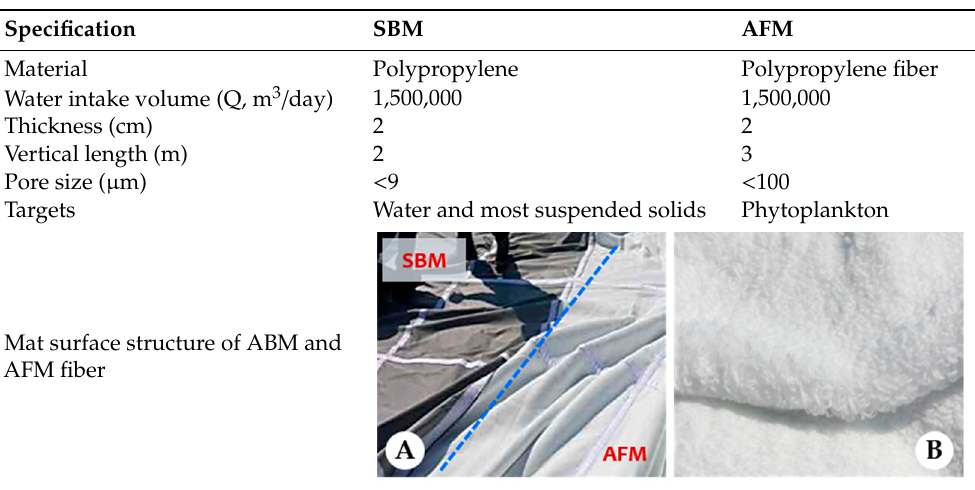
Table 1. Characteristics of the alternative algae-blocking mat (ABM) comprising a simple blocking mat (SBM) and an algal-filtering mat (AFM) that were used in this study. The dotted blue line indicates where both SBM and AFM are connected, whereas B is the surface structure of AFM fiber.